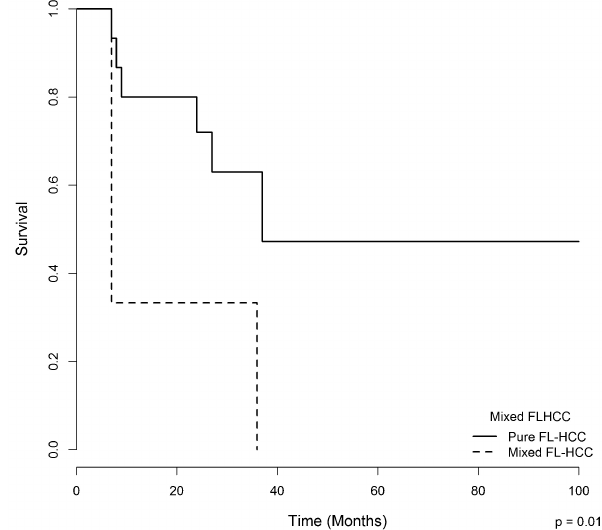
Figure 3 - (A) Overall disease-free survival of resected patients with fibrolamellar hepatocellular carcinoma according to vascular invasion. Vascular invasion, either macro- or microscopic, was associated with an increased risk of tumor recurrence (Cox regression, p , 0.01). (B) The overall survival of patients with fibrolamellar hepatocellular carcinoma according to the presence of vascular invasion. On the one hand, the presence of macrovascular invasion had a significant impact on survival; on the other hand, although the microvascular invasion data may suggest a trend, the small number of cases (3) did not allow for a significant discrimination with cases without any & DISCUSSION one-year survival rate (87.5%) compared with those who underwent chemotherapy, surgery plus chemotherapy, and FLHCC is an infrequent primary liver tumor presenting palliative care (66%, 60%, and 50%, respectively, p =0.05) significant epidemiological and clinical differences compared (Figure 5). with conventional hepatocellular carcinoma. Although the real incidence and clinicopathological features of FLHCC in Latin America remain poorly understood due to scarce available information (6-8), the present study of 21 cases from